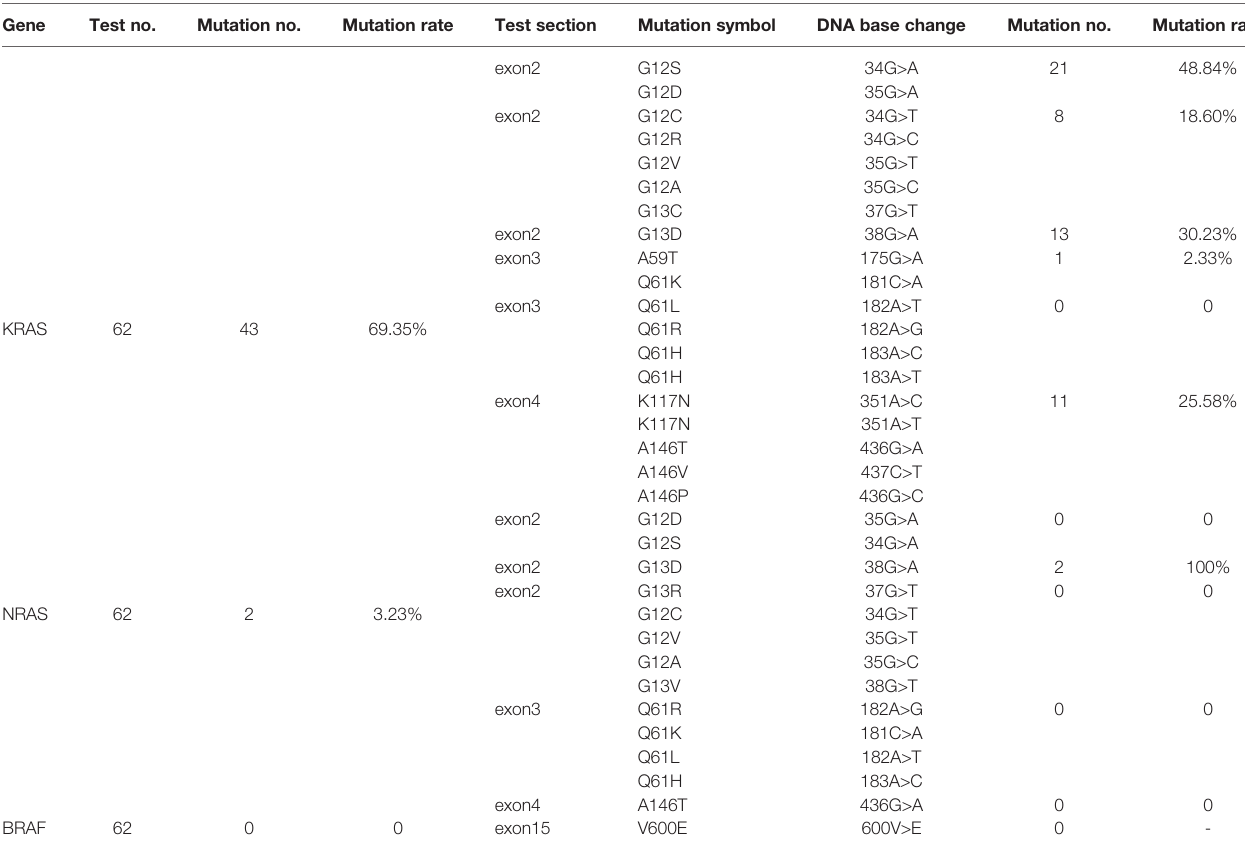
TABLE 1 | KRAS, NRAS, and BRAF mutation sites and rates in patients with ECRC. Gene Test no. Mutation